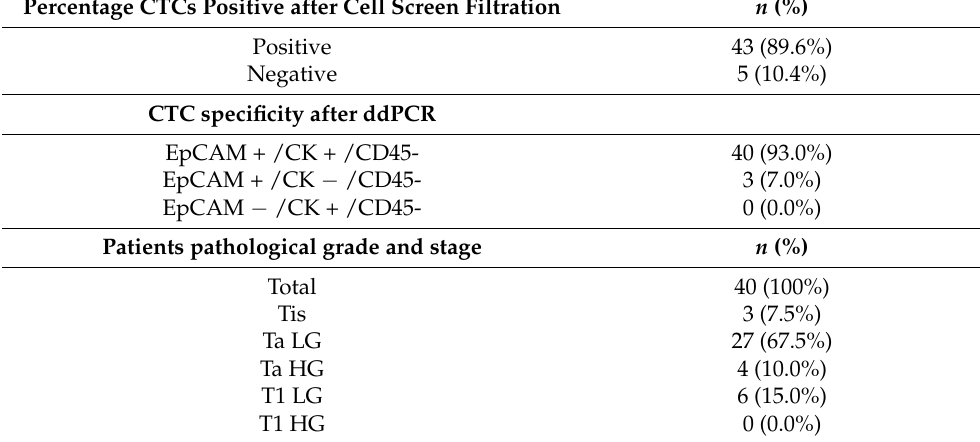
Table 3. Blood patients’ CTCs.